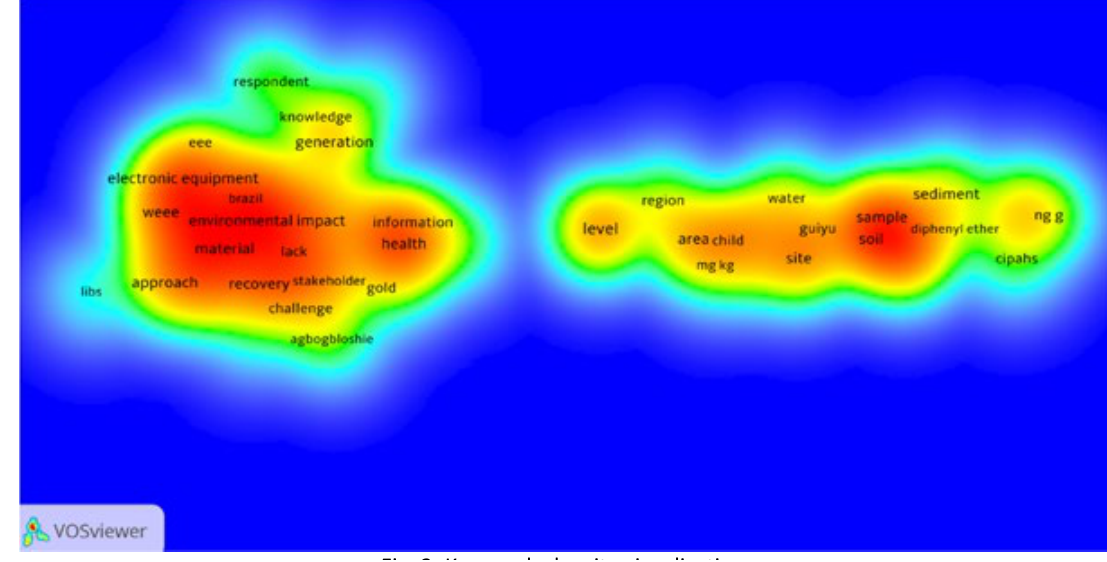
Fig. 3: Keywords density visualisation map